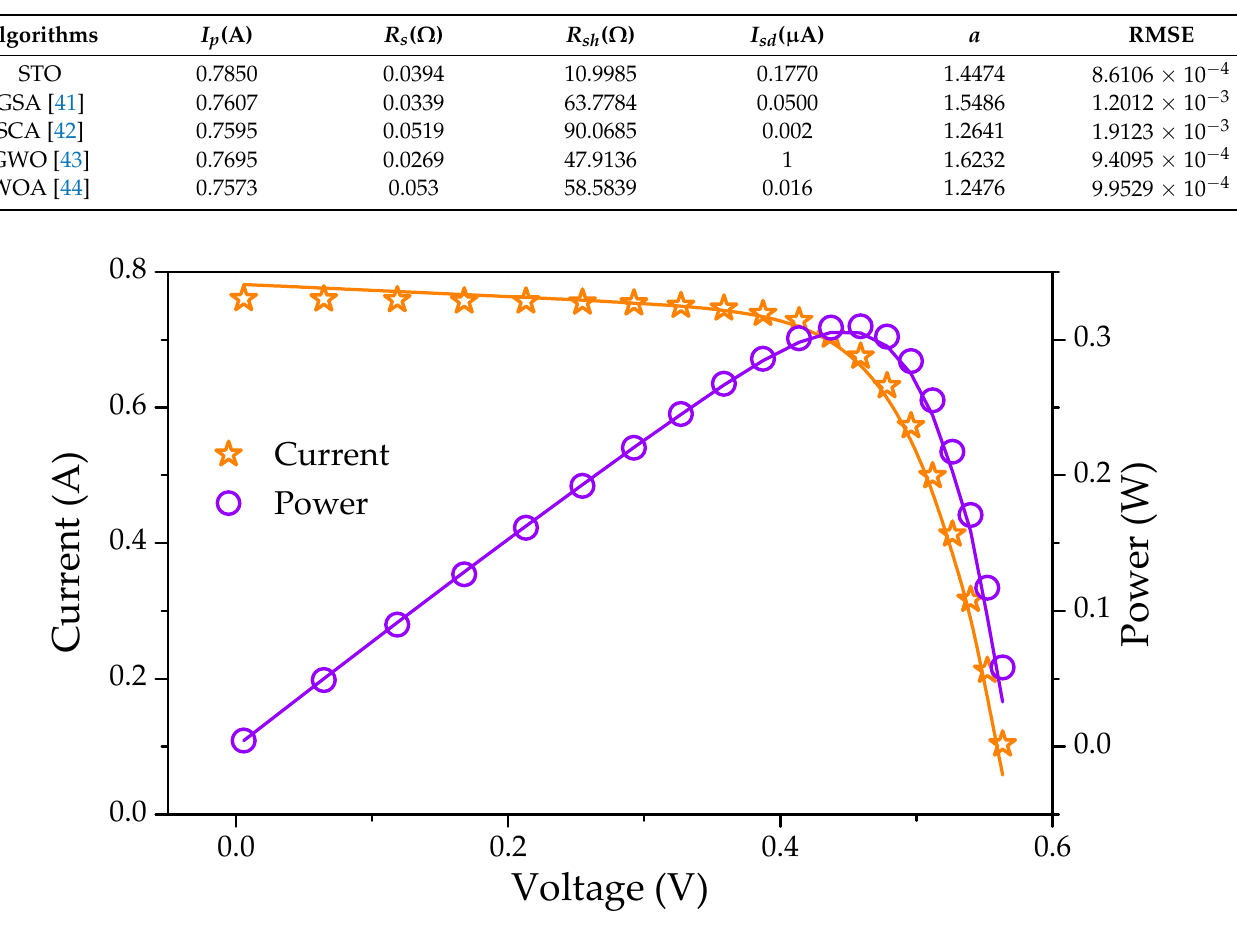
Figure 3. The simulated and experimental I-V and P-V characteristics curves for the single-diode model of the R.T.C France solar cell. Symbols indicate measured data, while solid lines indicate optimized data.